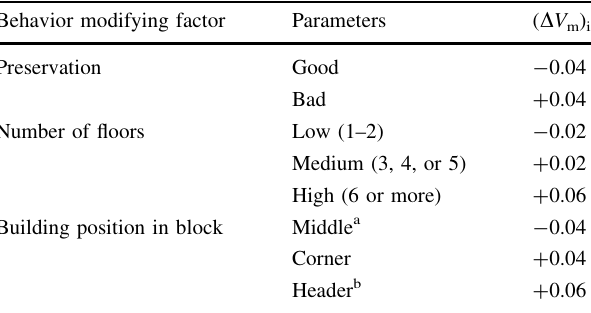
Table 3 Behavior modifying factors for masonry buildings. Source : Milutinovic and Trendafiloski (2003)